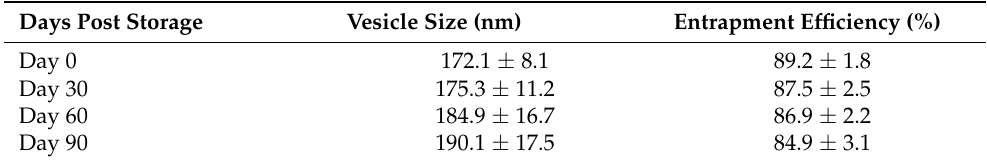
Table 3. Physical stability of optimized